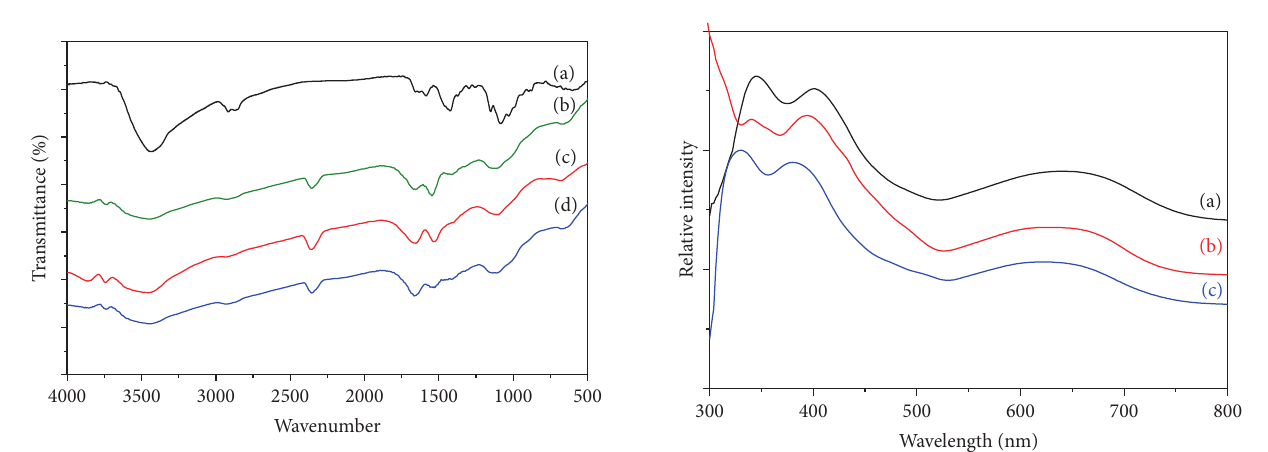
Figure 2: UV-vis diffuse reflectance spectra of (a) CGPNMA, (b) CGP2MA, and (c) CGP3MA.